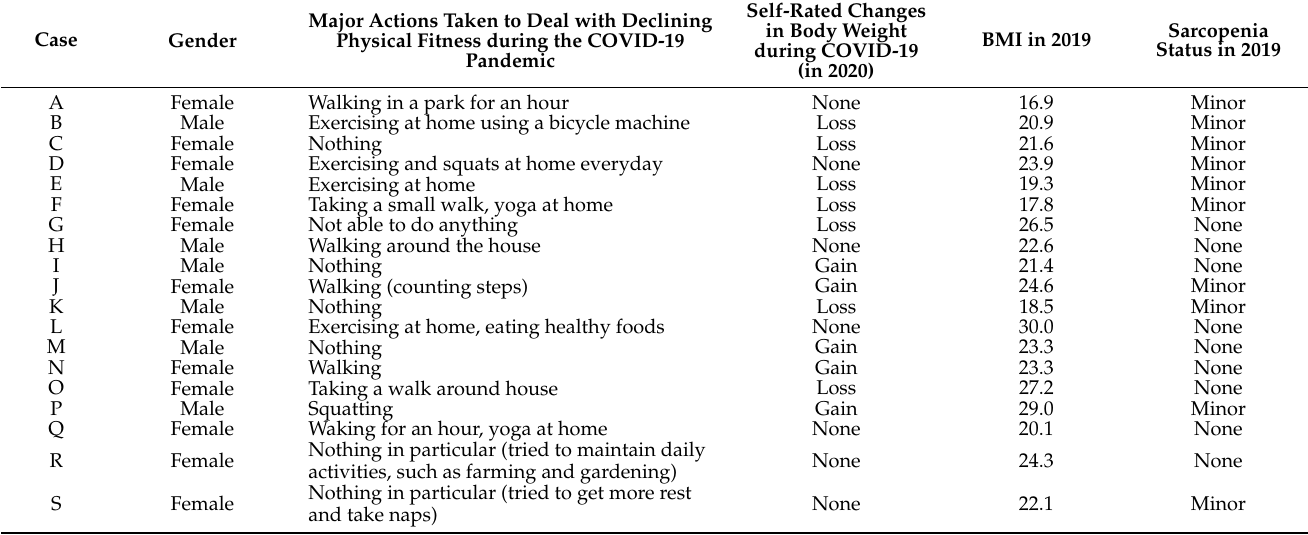
Table 1. Baseline characteristics of the participants.